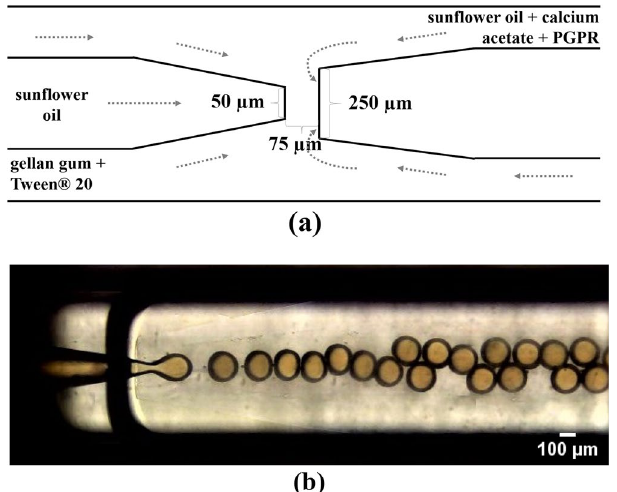
Figure 10. Three-dimensional coaxial microfluidic device used to produce gellan gum microcapsules. ( a ) Sketch of the microcapillary geometry for generating O/W/O templates and ( b ) Image of double emulsion